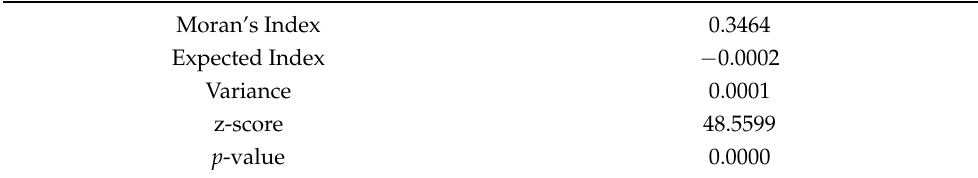
Table 6. Measures of spatial autocorrelation for the OLS